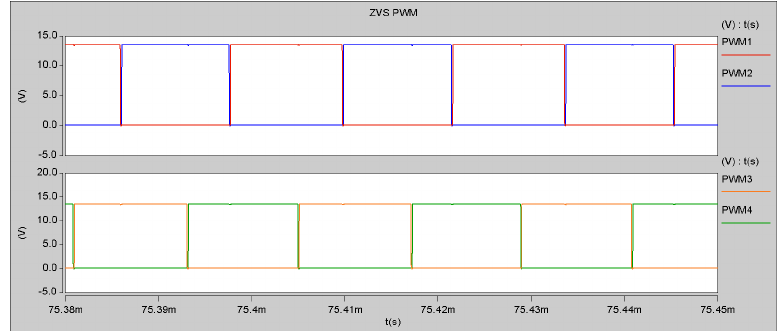
Figure 13. Four-phase PWM drive waveforms of A, B, C, and D.